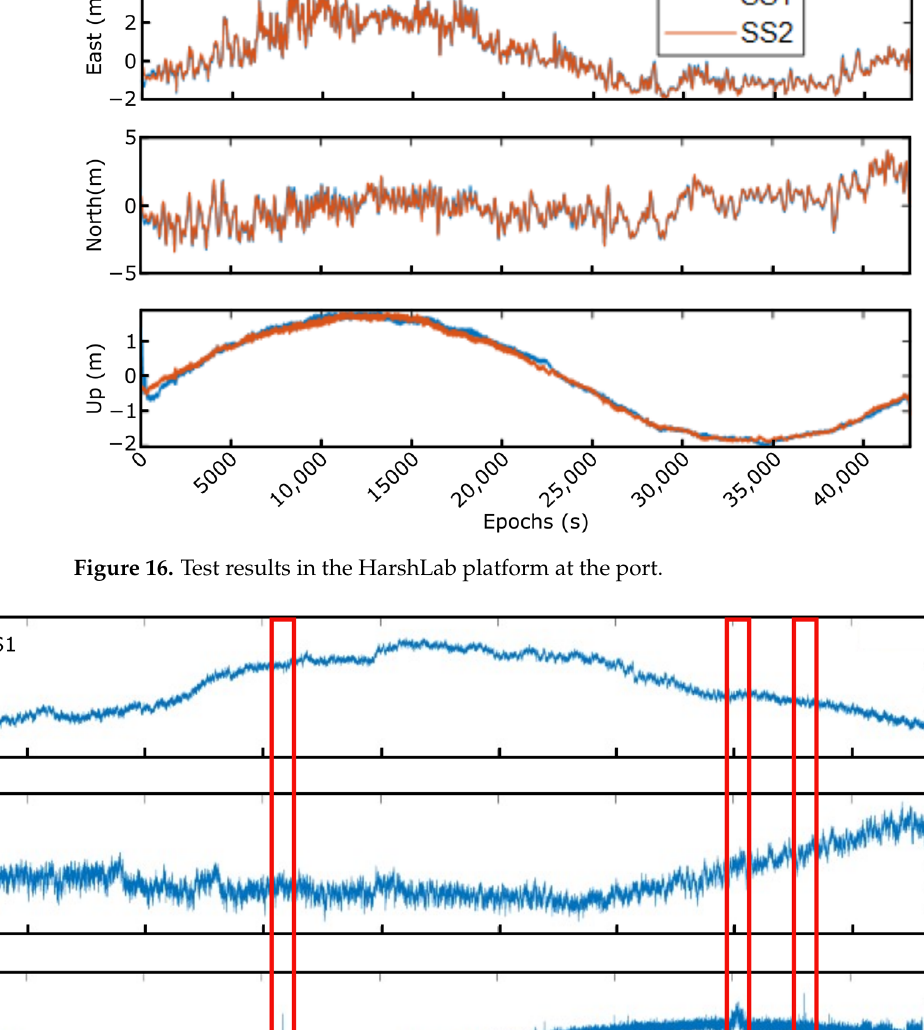
Figure 15. Solution rotating around A and B simultaneously: ( a ) 18 h, ( b ) 1 h.